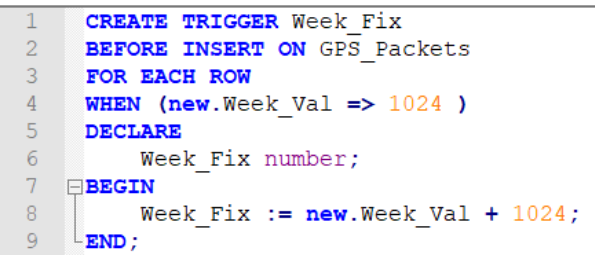
Figure 4. Simple trigger creating process over a trial database used to store and handle GPS NMEA packets, a simple process is applied before any data are entered into the database for processing.